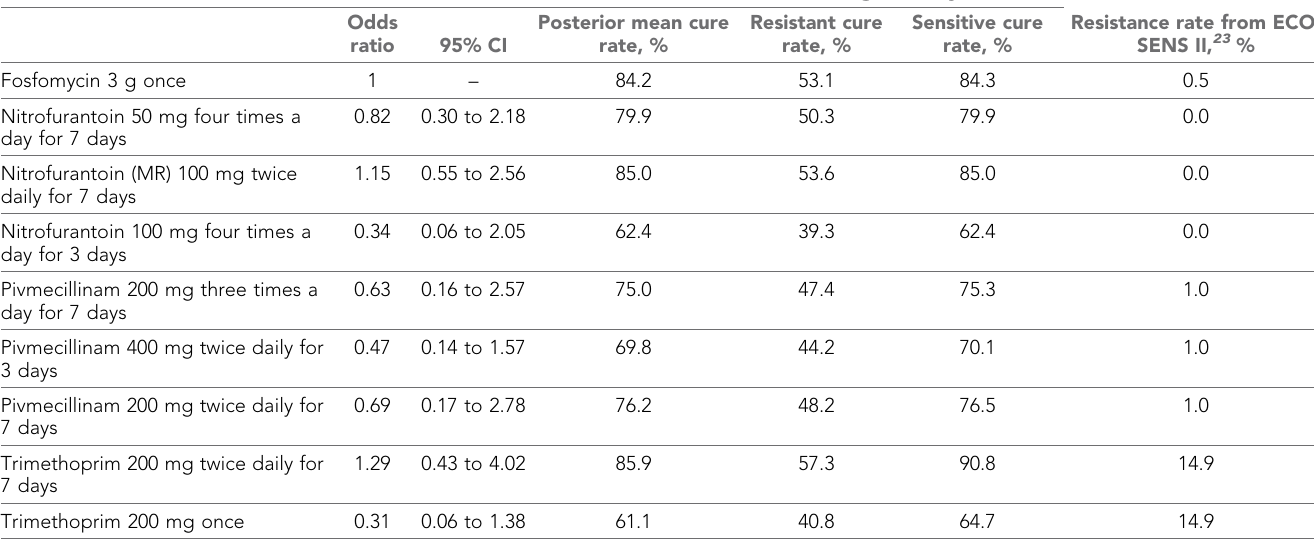
Table 1. Results of the network